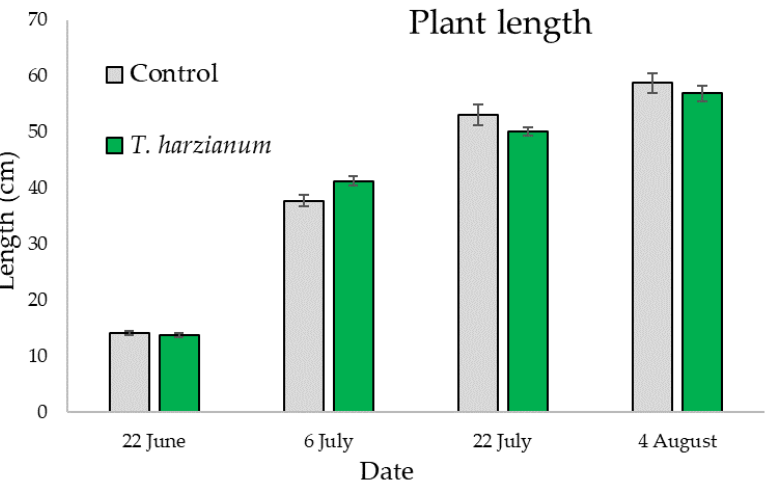
Figure 9. Mean values ( ± standard errors) of the length of zucchini plants inoculated with T. harzianum T22 and control on the four sampling dates.